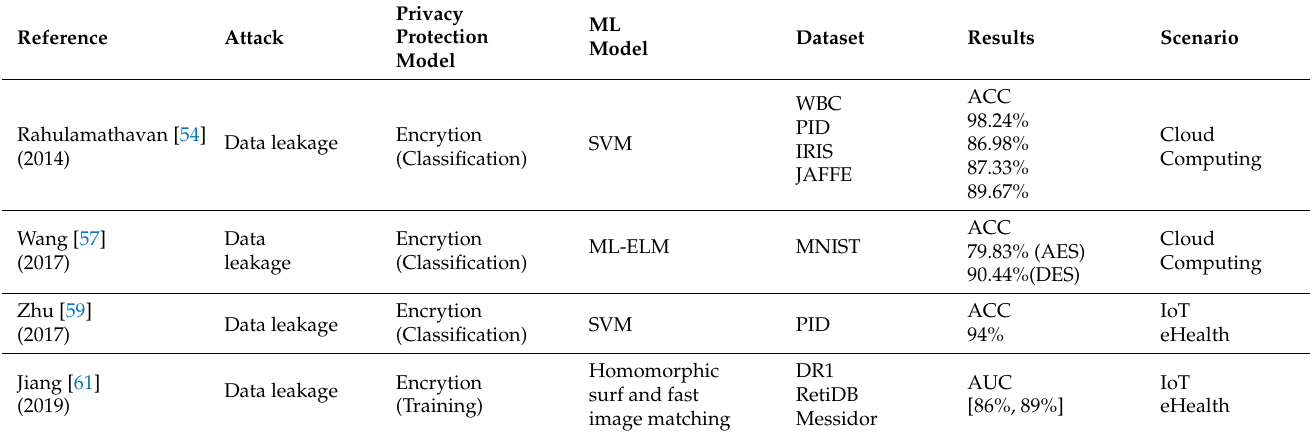
Table 2. ML-based privacy works in IoT environments—Centralized